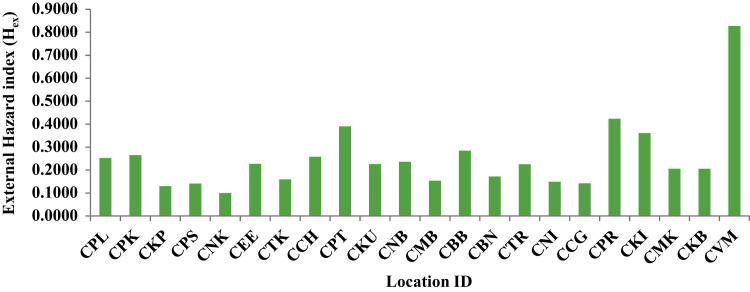
Location ID Vs External Hazard Index (Hex).